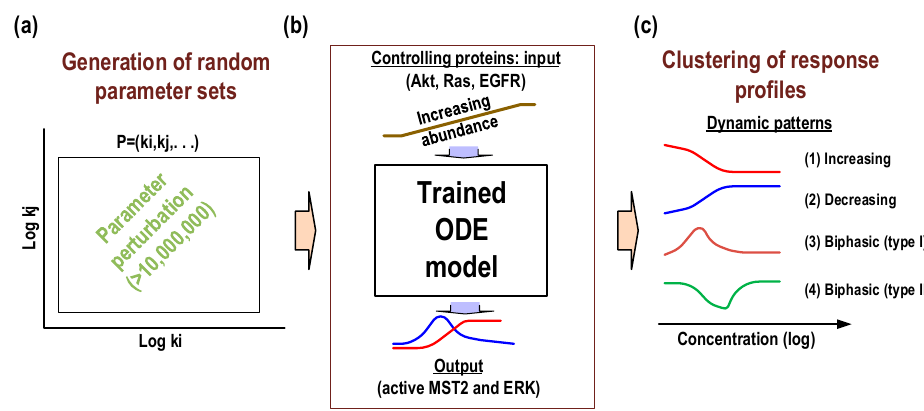
Figure 3. Illustration of the simulation procedure for response pattern clustering. The kinetic parameters underlying six critical regulatory links (denoted F 1 to F 6 in Figure 1) are systematically varied within large ranges around their nominal values between 10 − 3 and 10 3 fold of the fitted values. A large number (>10 million) of parameter sets were generated ( a ); The steady-state response profiles of active MST2 and ERK for each set were simulated to increasing expression of the controlling proteins (i.e., Akt, Ras and EGFR) ( b ); Diverse profile profiles of the Hippo-ERK network are clustered into distinct four different response patterns ( c ).